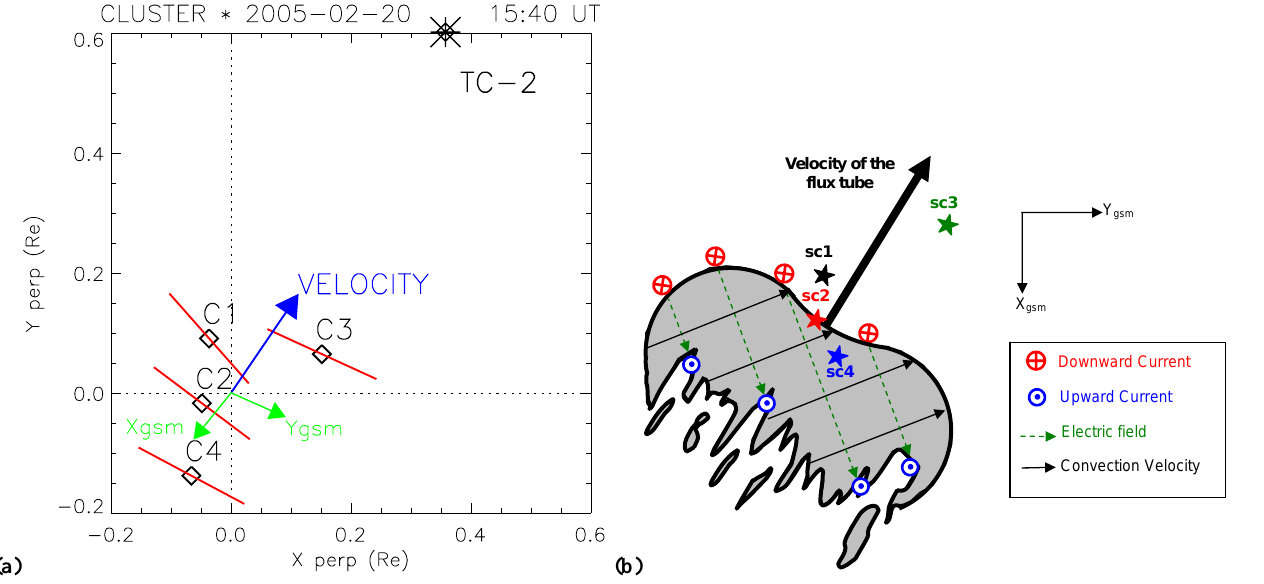
Fig. 9. (a) Polarisation direction at each Cluster spacecraft at the beginning of Injection 3 (15:40UT) in the plane perpendicular to the magnetic field. The relative position of TC-2 is indicated by a star/diamond symbol, with the centre of mass of the Cluster tetrahedron at the origin. The X and Y axis of the GSM frame have been projected onto this plane (green arrows). The blue arrow represents the velocity of Injection 3 ( ∼ 15:40UT). (b) Sketch of the transverse shape of Injection 3 deduced from the magnetic variance analysis, and of the electrodynamics of the structure. The black arrows represent the convection velocity, the bold black arrow represents the velocity of the flux tube, the green dashed arrows represents the convection electric field. The blue dots and red crosses represent upward and downward